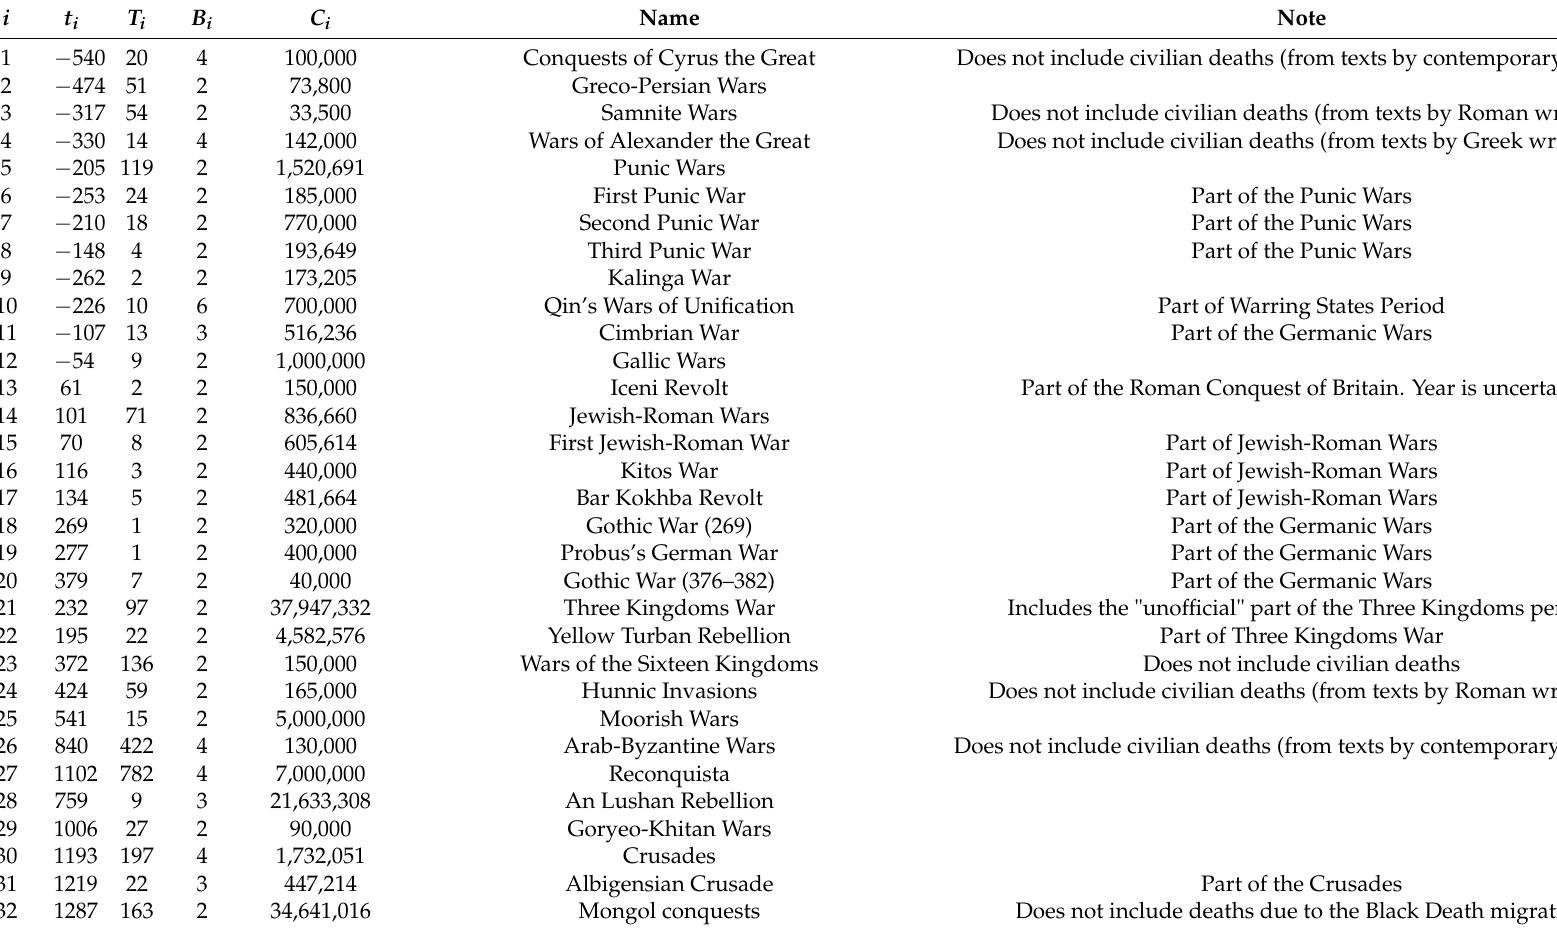
Table A1. List of 163 wars with more that 25,000 casualties (adapted from: